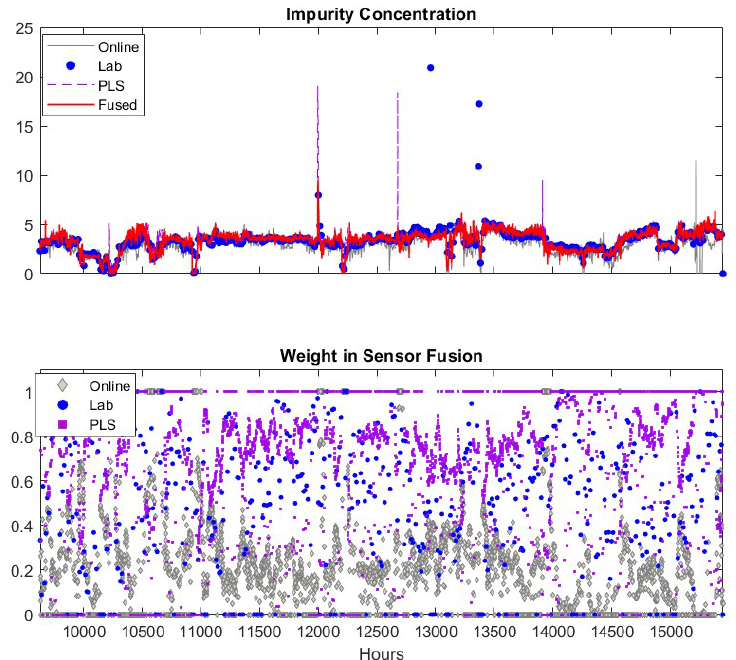
Figure 6. Fusion of filtered online analyzer data with other sensors. Upper figure: lab data (●), filtered online analyzer data (–), Adaptive PLS software sensor data updated as shown in Figure 4 (--) and fused value ( ─ ). Lower figure: Weights of lab data (●), online analyzer data ( ♦ ), PLS software sensor data ( ■ ).